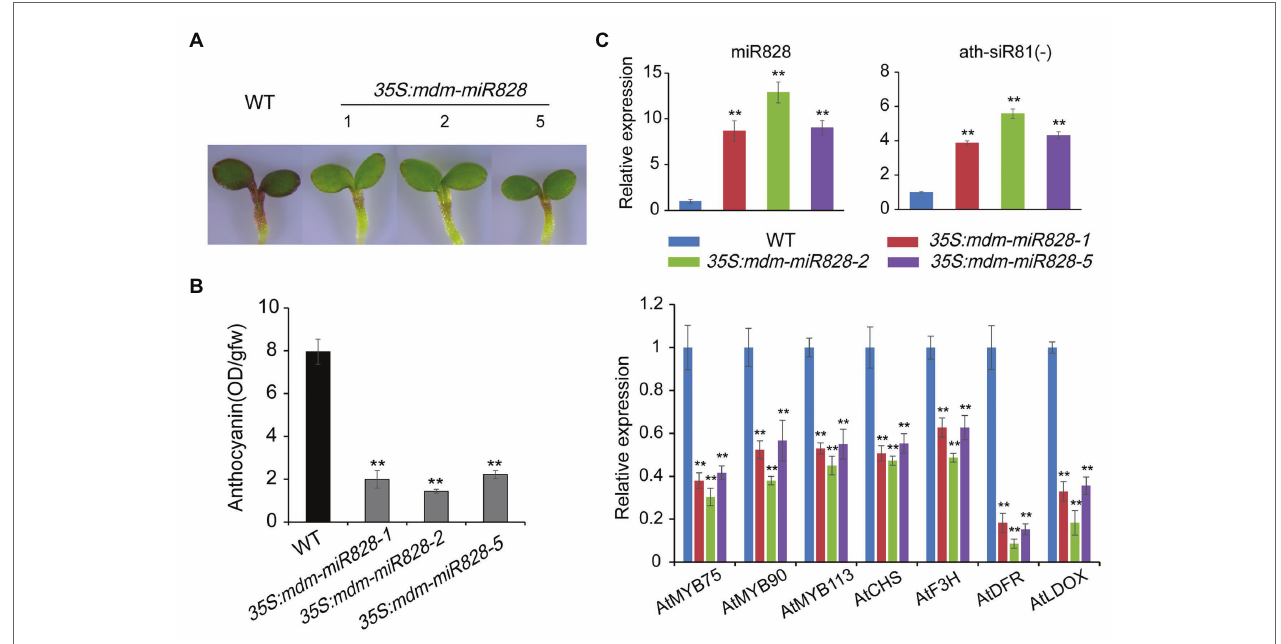
FIGURE 3 | Overexpression of mdm-miR828 inhibits anthocyanin accumulation in Arabidopsis seedlings. (A) Phenotypes of mdm-miR828-overexpressing and wild-type Arabidopsis grown on half-strength Murashige and Skoog medium supplemented with 2% sucrose for 4 days. 35S:mdm-miR828-1, 35S:mdm-miR828-2, and 35S:mdm-miR828-5 represent three transgenic lines. (B) Anthocyanin content in mdm-miR828-overexpressing and wild-type Arabidopsis . (C) Relative expression levels assessed by qRT-PCR analysis showed that mdm-miR828 overexpression affects expression of anthocyanin-related genes in Arabidopsis . Error bars represent the standard deviation of three biological replicates. ** p < 0.01 (Student t